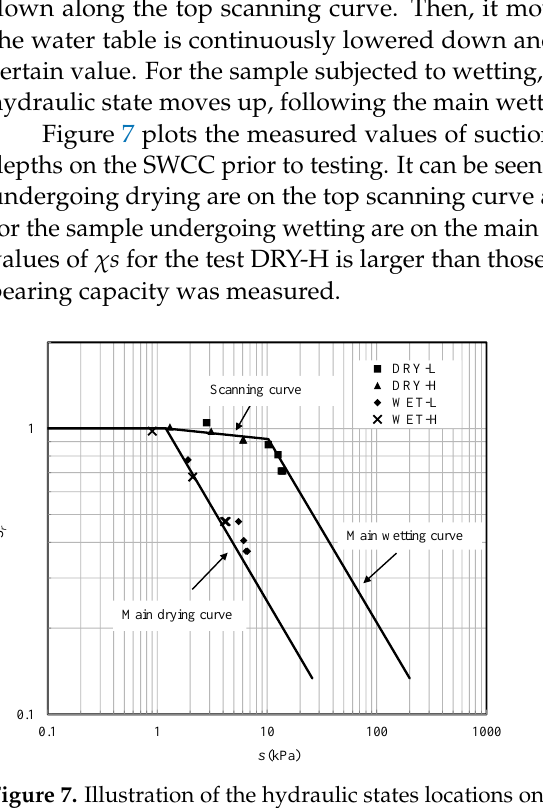
( b ) Figure 8. Assumed χs profiles for unsaturated soil samples subjected to ( a ) drying; ( b ) wetting. For the sample undergoing drying, the χs profile is assumed as χs = 11.4 − 8 z when the water table is at the soil – gravel interface and χs = 6 − 20.8 z when the water table is at a height of 240 mm. For the sample undergoing wetting, the χs profile is assumed as χs = 2.62 − z when the water table is at the soil – gravel interface and χs = 2.45 − 6.5 z when the water table is at a height of 240 mm.